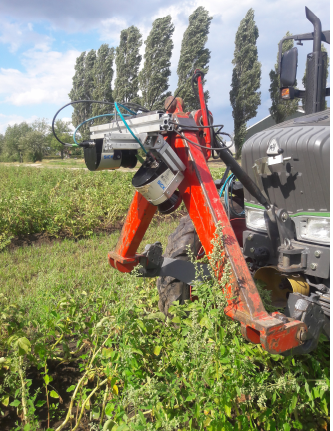
Figure 1. The sensor setup mounted to the tractor’s three-point linkage. Here shown while scanning a different